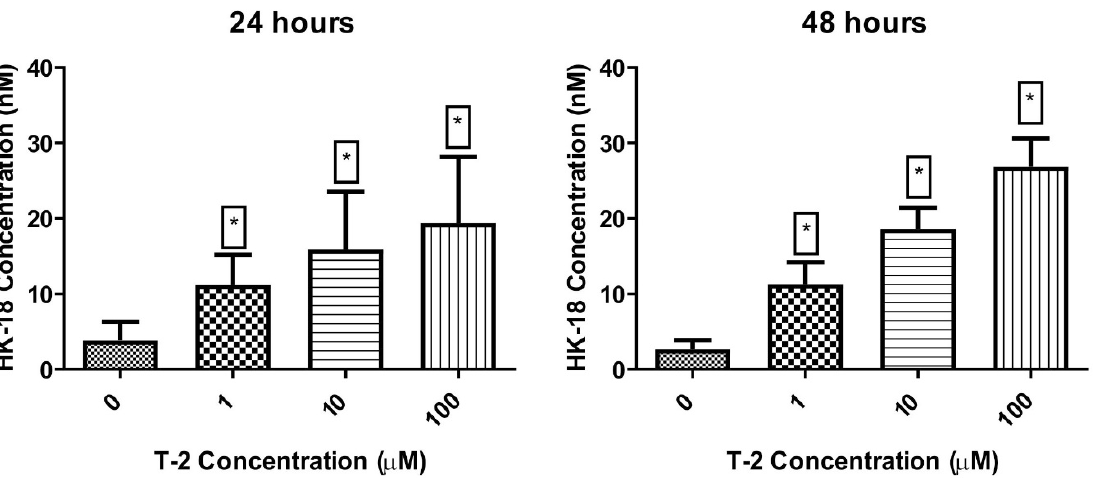
Figure 6. The T-2 effect on full-length Human Cytokeratin 18 concentration in Hs68 cells. Concentration was measured using ELISA method with absorbance measured at λ = 450 nm. Values: means ± SD ( n = 6). * p < 0.001. 0: untreated (control) cells; 1: concentration of toxin—1 µM; 10: concentration of toxin—10 µM; 100: concentration of toxin—100 µM.